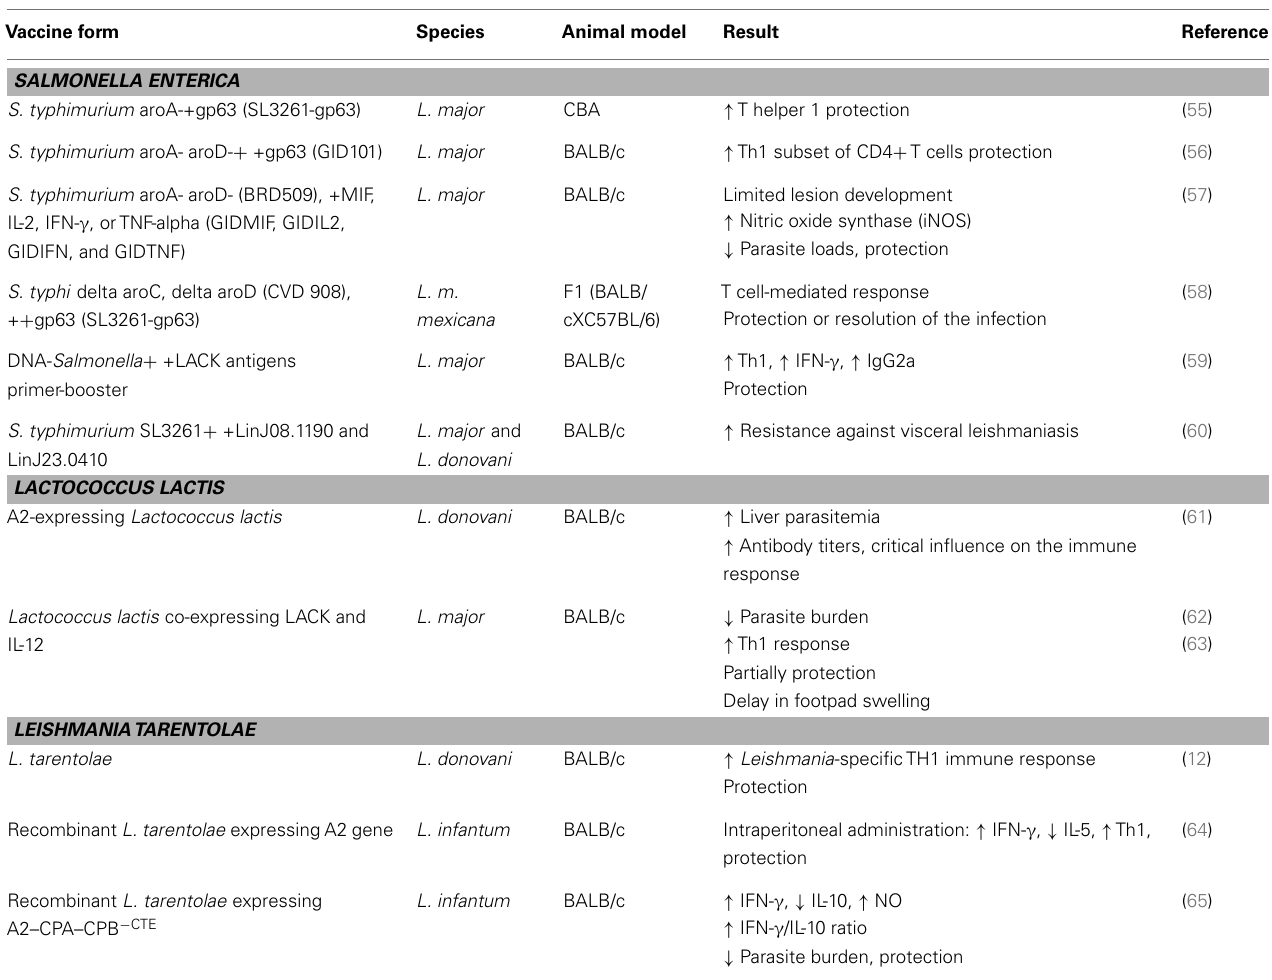
Table 3 | Live non-pathogenic vaccines against leishmaniasis